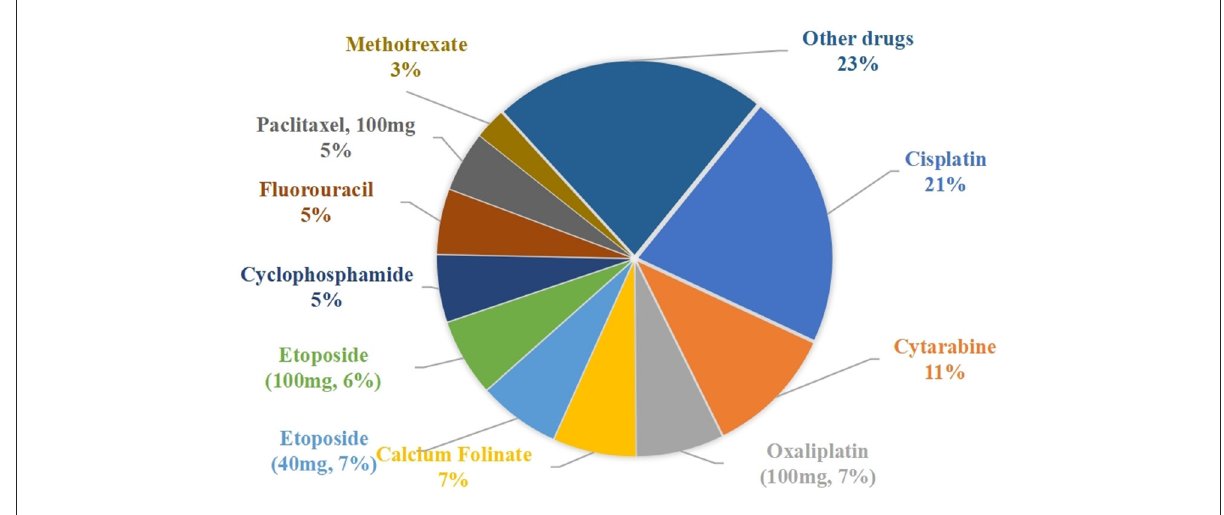
FIGURE4 Percentage of waste-generating drug prescriptions.